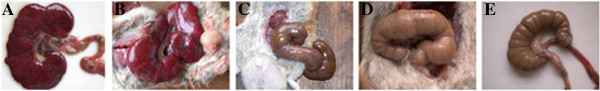
Changes of intestine loop in all groups at the end of experiment. (A&B) Enlarged and bleeding cecum and upper colon without formed stool in the control group; (C) Slightly dilated cecum in the empty plasmid group, with high tension, hydropsia, congestion and no formed stool; and (D) Cecum of the secreted-protein and membrane-anchored plasmid groups, with formed stool and no sign of congestion, bleeding, or dilation (E).